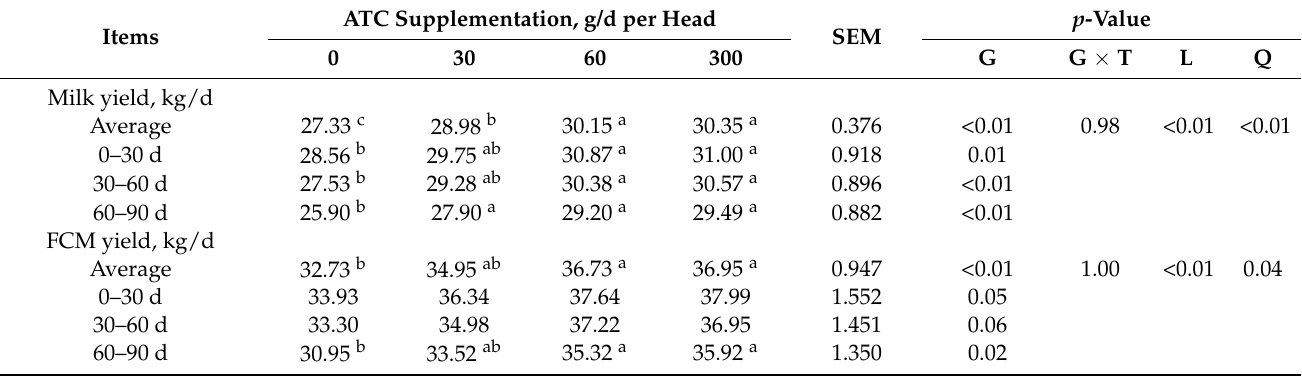
Table 2. Effects of different amounts of Acremonium terricola culture on milk performance in lactating dairy